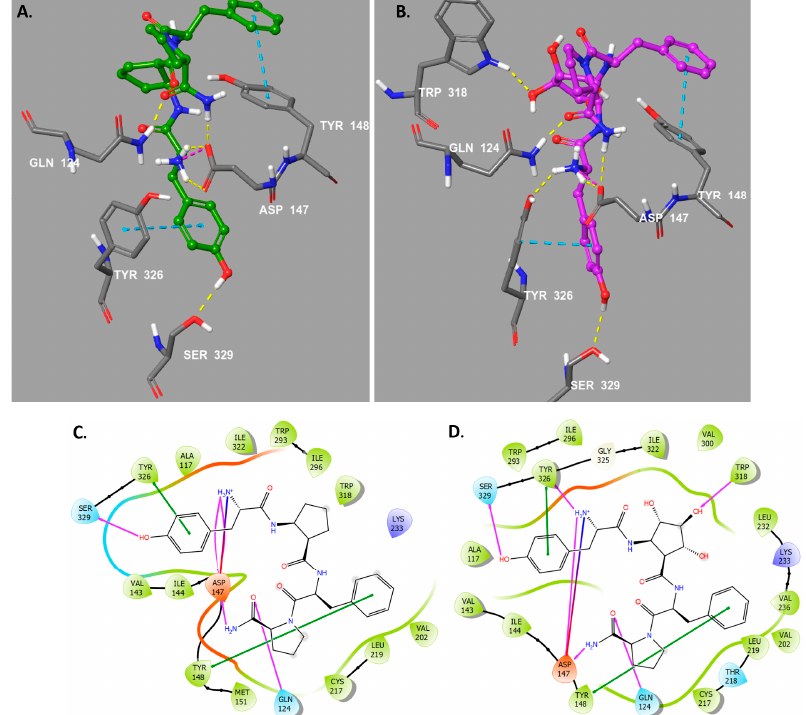
Figure 3. ( A ) Binding mode of compound 4 . ( B ) Binding mode of compound 5a . Blue lines indicate π -cation interactions and purple lines salt bridges. Residues of the receptor MOR are represented in gray, 4 in green and 5a in purple. ( C ) Two-dimensional diagram of the main interactions between 4 and the residues involved in ligand recognition of the MOR binding site. ( D ) Two-dimensional diagram of the main interactions between 5a and the residues involved in ligand recognition of the MOR binding site. Purple lines represent hydrogen bonds, blue-red represent salt bridges, red lines represent π -cation, and green lines represent π -stacking. Hydrophobic residues are represented in green, negatively charged in red, polar in light blue and positively charged in purple.